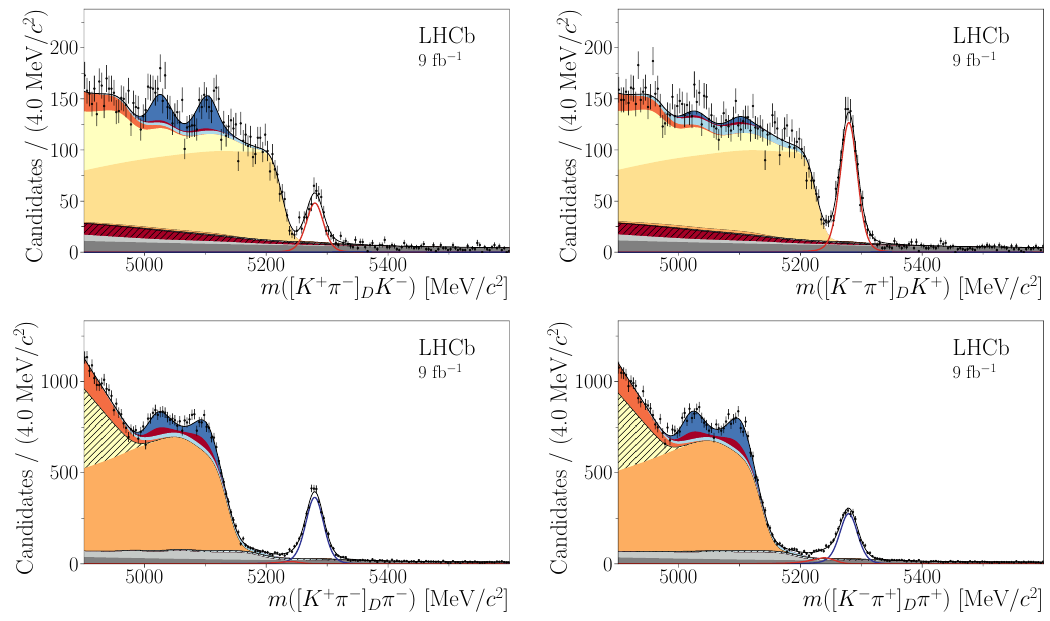
Figure 3 . Invariant-mass distribution of B ± → [ K ∓ π ± ] D h ± candidates with the fit result overlaid. A legend is provided in figure